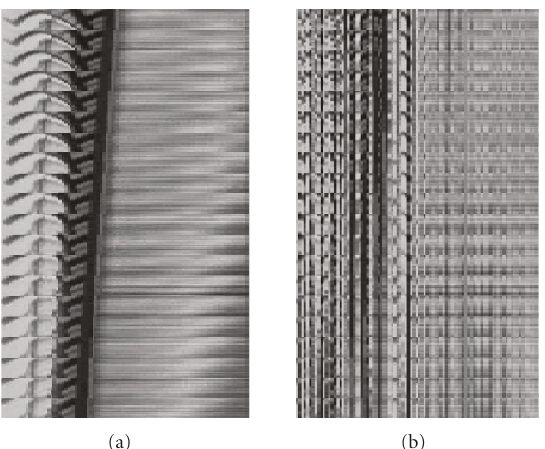
Figure 1: the sorting result based on R -values on 100 frames of a 20 × 20 test block. (a) Matrix A . (b) Matrix where its columns are sorted based on QR-decomposition’s R